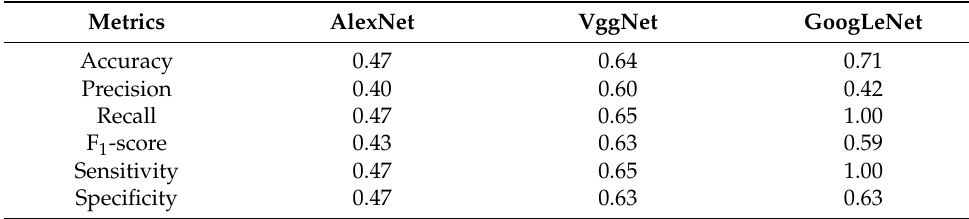
Table 10. Metric comparison under hairstyle change.